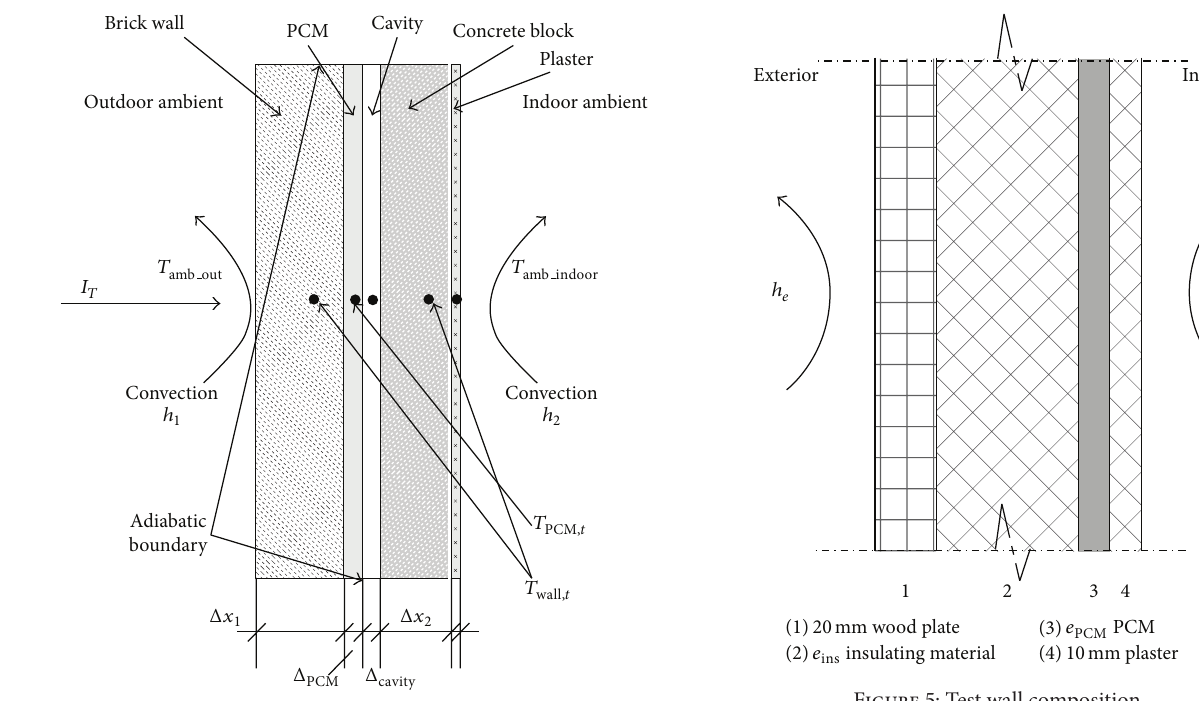
Figure 4: A schematic diagram illustrating the heat transfer in a PCM augmented wall.